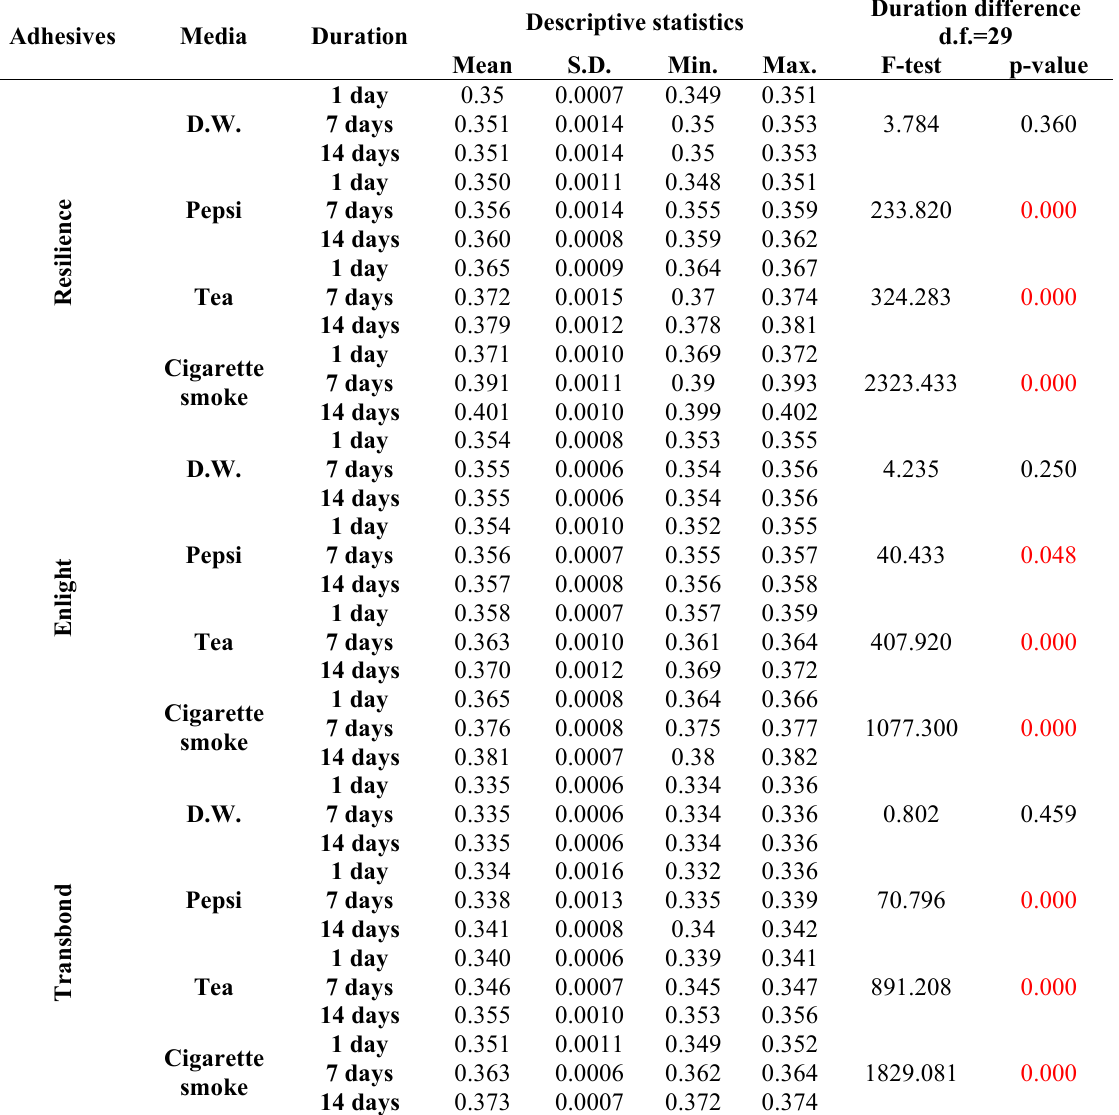
Table 3: Descriptive statistics of light absorption and duration difference in each media for the brackets bonded with Resilience, Enlight and Transbond adhesives.